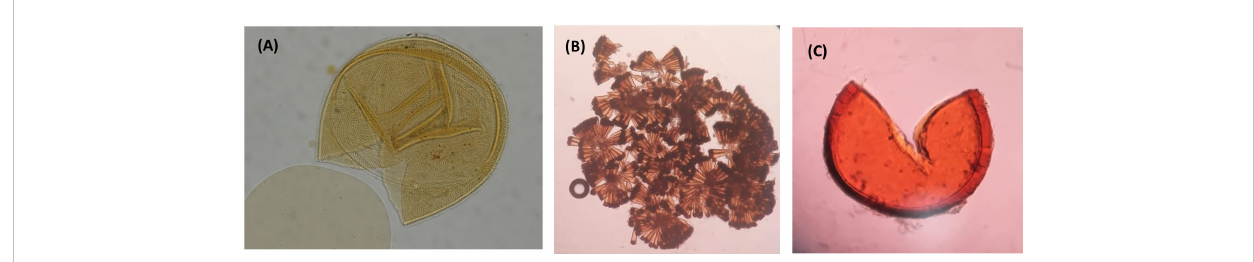
FIGURE 5 Morphological characterization of AMF spores present in the rhizosphere of seedlings of the genus Inga in the Ecuadorian Amazon. (A) Microscopic image of a spore of Acaulospora spinosa; (B) Microscopic photo of the remainings of a sporocap contributed to the genus Sclerocystis ( Glomus sp.) (C) Photo of the characteristic spore characteristic for AMF belonging to Gigaspora